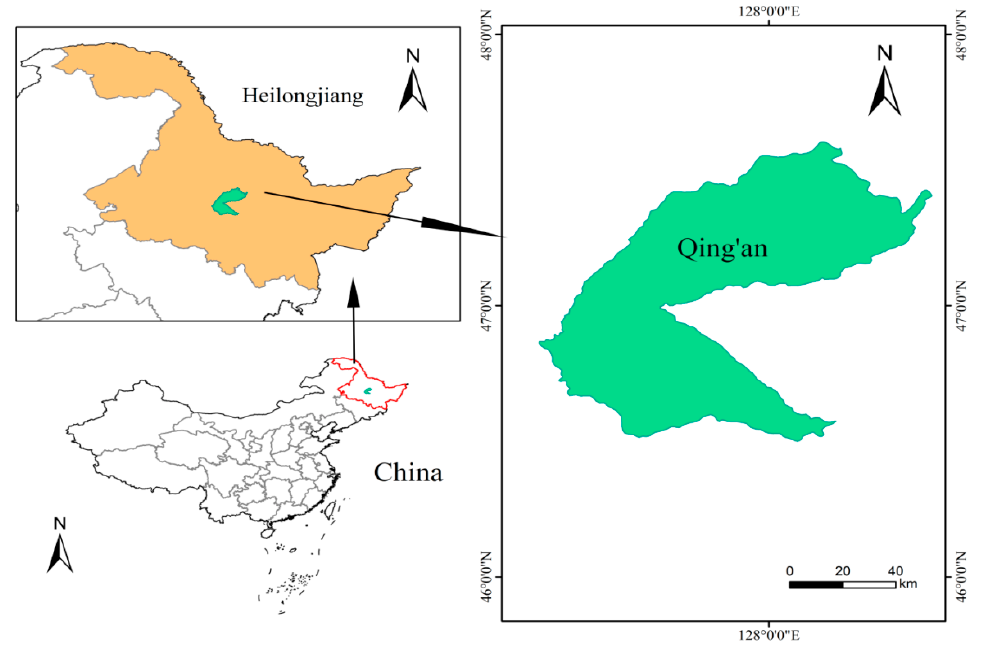
Figure 1. Study area.